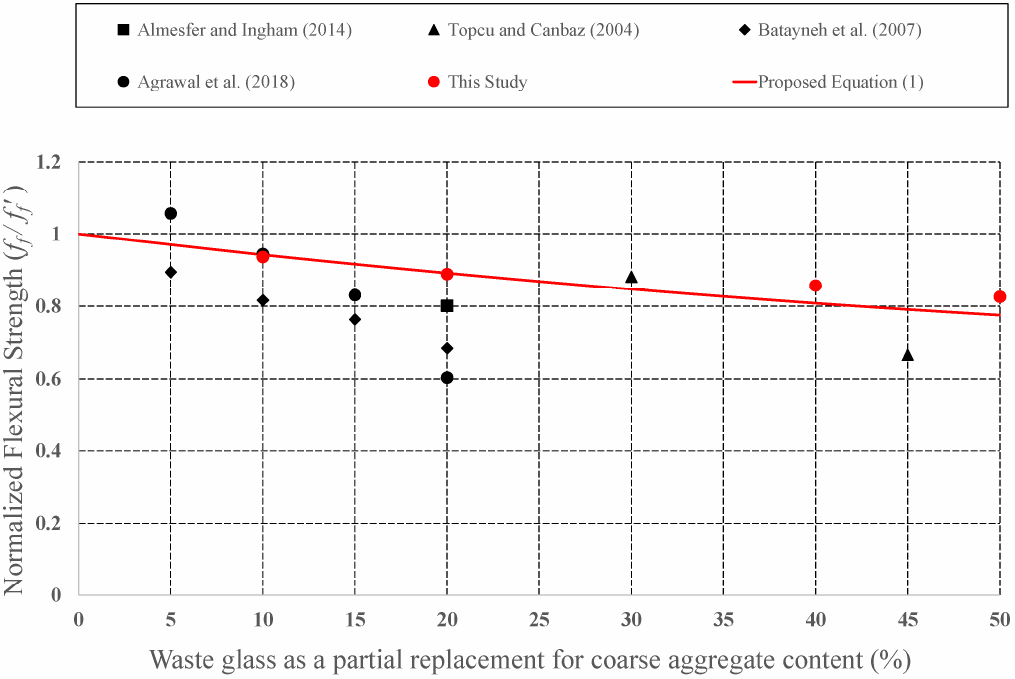
Figure 10. Discrepancy of the normalized FS of the concrete produced with CWG as a partial replacement for CA [40,47,57,79].